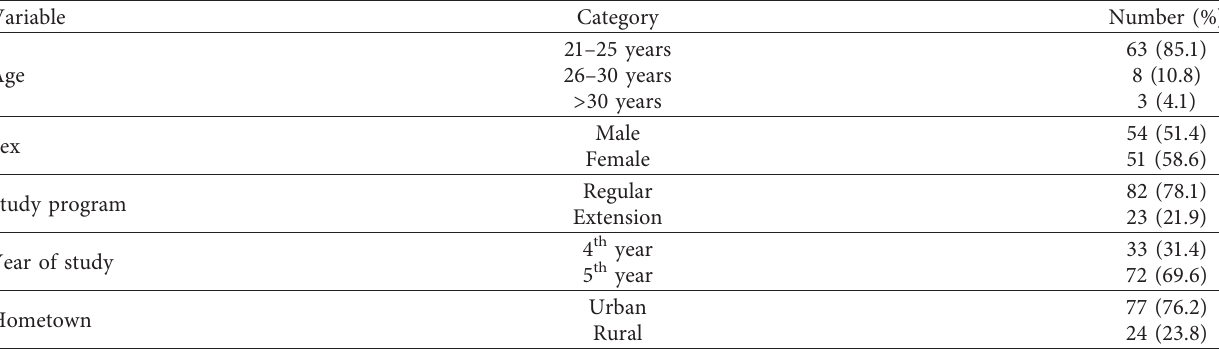
Table 1: Demographic characteristics of the